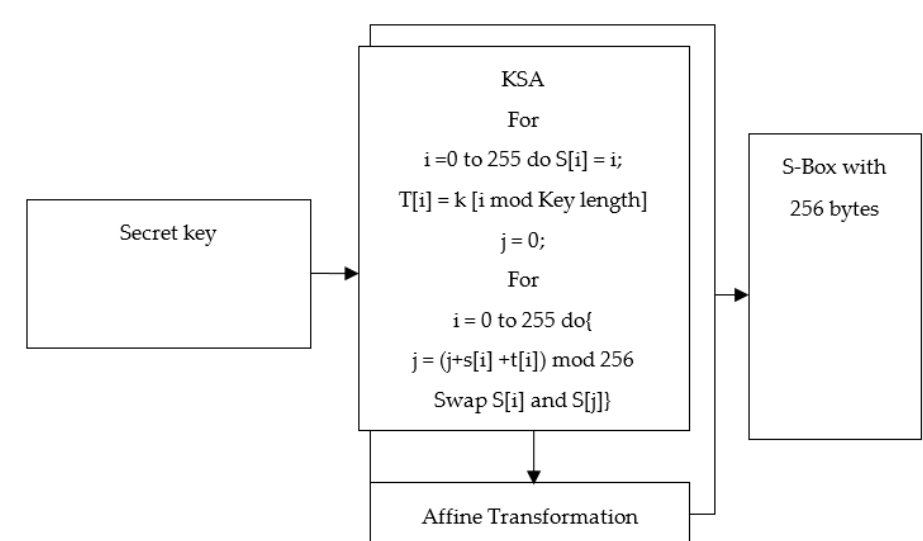
Figure 2. Block diagram of the key dependent S-Box RC4 algorithm.